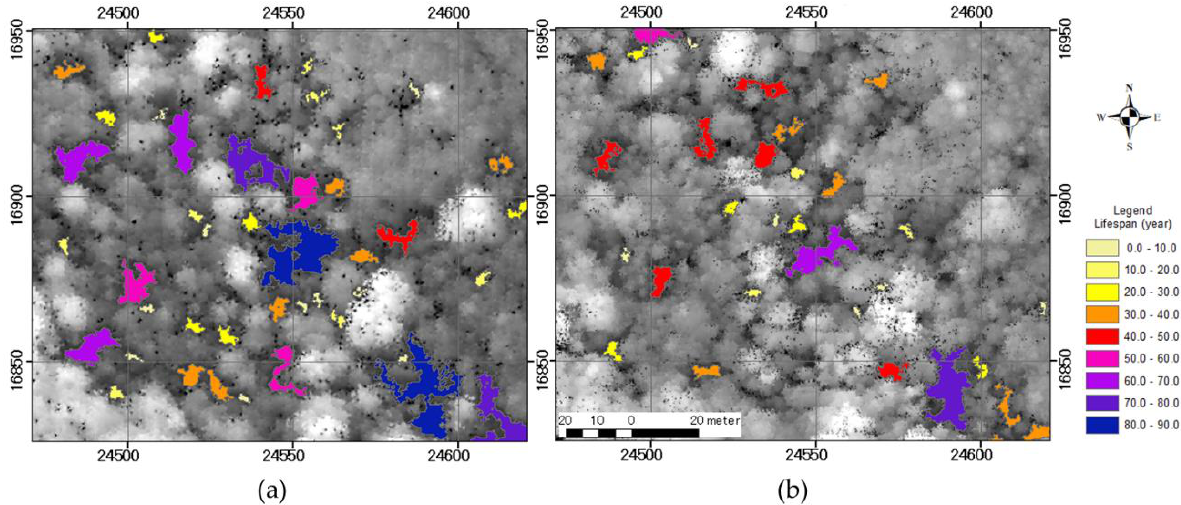
Figure 11. Gap lifespan predicted by the relationship between initial gap area and shrinkage. ( a ) Prediction using the gap map in 2005 ( b ) and in 2016.